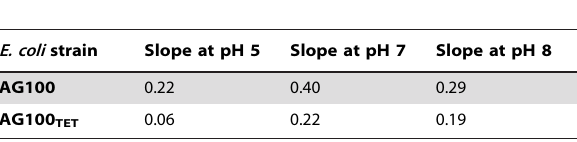
Table 1. The growth rates of E. coli AG100 and AG100 TET in MH at pH 5, 7 and